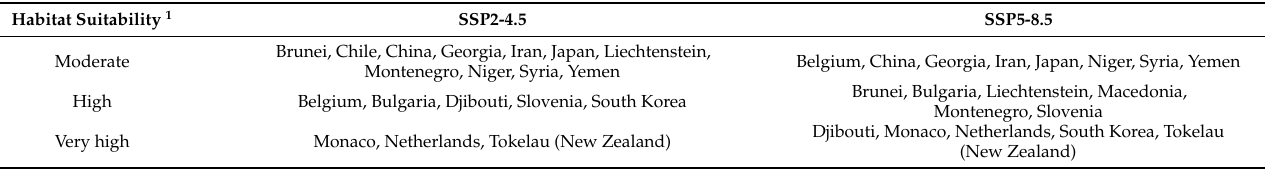
the moderate, high, and very high habitat suitability categories by 2081–2100 under the future climate scenarios SSP2-4.5 and SSP5-8.5. The habtiat suitability value of each category is presented in Table